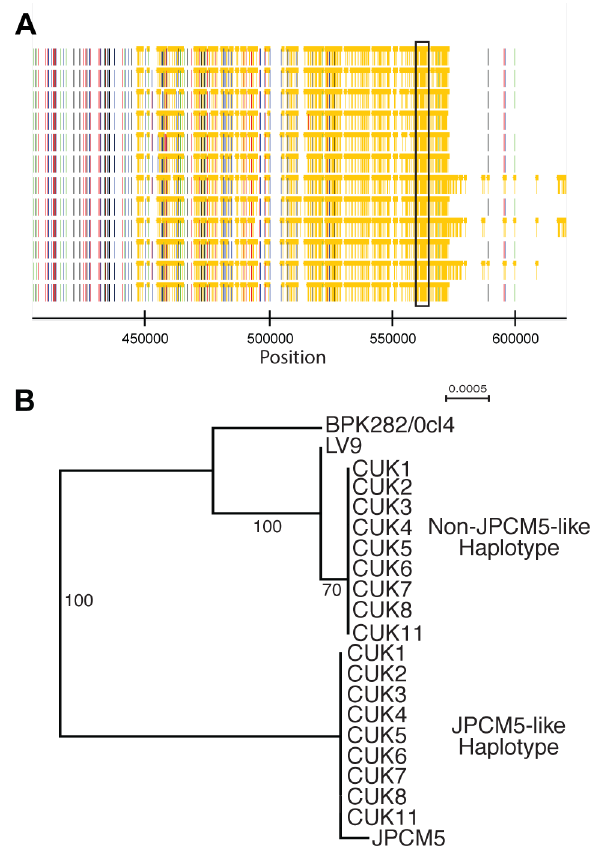
Figure 2. Phased haplotypes help identify one of the parental strains. (A) A heterozygous SNP-dense region of chromosomes 22 (boxed) was one of 86 regions that could be successfully phased to infer haplotypes of at least 5 kb in at least one CUK strain. This region could be phased in 9 strains. (B) Phylogenetic analysis of this region confirms that the two haplotypes have different evolutionary histories: one related to L. infantum JPCM5 and the other distantly related to the two L. donovani reference